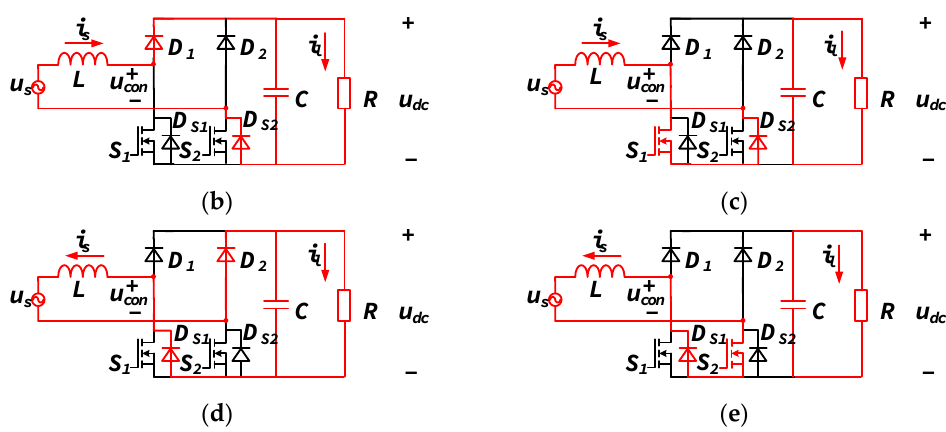
Figure 1. Main topology of the bridgeless rectifier and its four operation modes: ( a ) Main topology of the bridgeless rectifier; ( b ) Mode I; ( c ) Mode II; ( d ) Mode III; ( e ) Mode IV. Due to the unidirectional conduction property of the fast recovery diodes, the value of the AC side voltage u con of the bridgeless rectifier depends on the switching state and the polarity of the input current. Thus, there are only four effective operation modes for bridgeless rectifiers as shown in